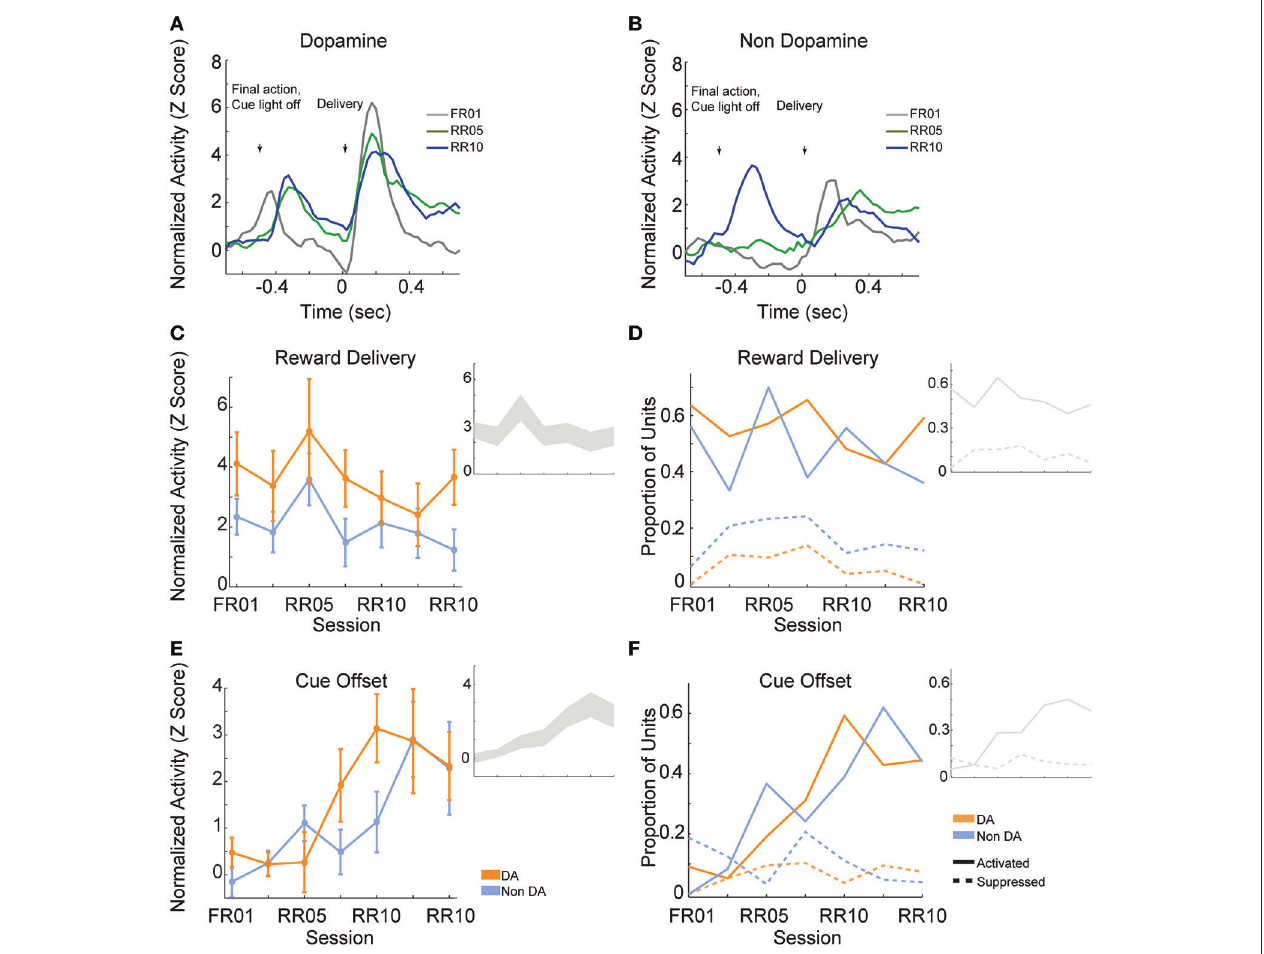
FIGURE 7 | VTA responses to rewards and reward predictive cues. Normalized mean (A) dopamine and (B) non-dopamine responses aligned to outcome delivery (time = 0). The final action in each trial (left arrow) occurred 0.5s prior to outcome delivery (right arrow). Cue light offset was simultaneous with execution of the final action, which signaled trial completion and impending outcome delivery. Data are depicted for FR01, final RR05 session, and the final RR10 session. (C) Mean ± SEM responses evoked by reward delivery ( + 0.05 to + 0.3 s, relative to reward delivery) in both groups of neurons and all sessions. Dopamine responses were greater than non-dopamine neuronal responses. Inset depicts data from all VTA neurons plotted without respect to neuronal classification. (D) The proportion of neurons classified as either significantly activated (solid lines) or suppressed (dashed lines) by outcome delivery. Data are depicted across all sessions for putative dopamine and non-dopamine neurons. Inset depicts data from all VTA neurons plotted without respect to neuronal classification. (E) Mean ± SEM responses following cue offset, during the pre-reward delivery period ( + 0.150 to + 0.400 s, relative to cue offset). Data are depicted similarly to (C) . In each group, the evoked response increased across sessions. (F) The proportion of neurons activated (solid lines) or suppressed (dashed lines) by cue offset signaling future reward delivery. Data depicted similarly to (D)